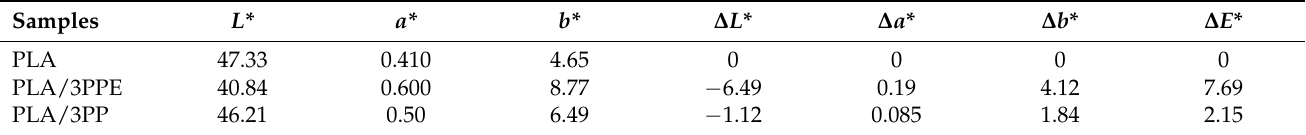
Table 2. Optical properties of the control (PLA) and active (PLA/3PPE and PLA/3PP)